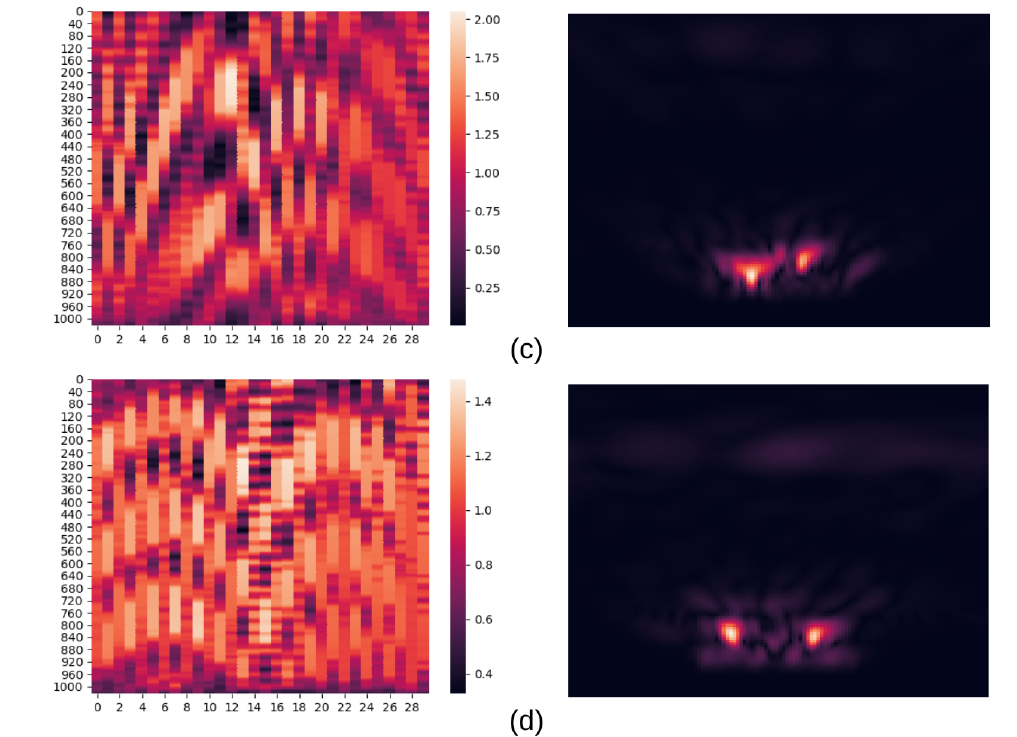
Figure 5. Pairs of RealSAR-RAW (left) and RealSAR-IMG (right) examples. Example pair ( a ) repre- sents an empty scene, ( b ) scene with an aluminium bottle, ( c ) scene with an aluminium and a glass bottle, while ( d ) contains all three